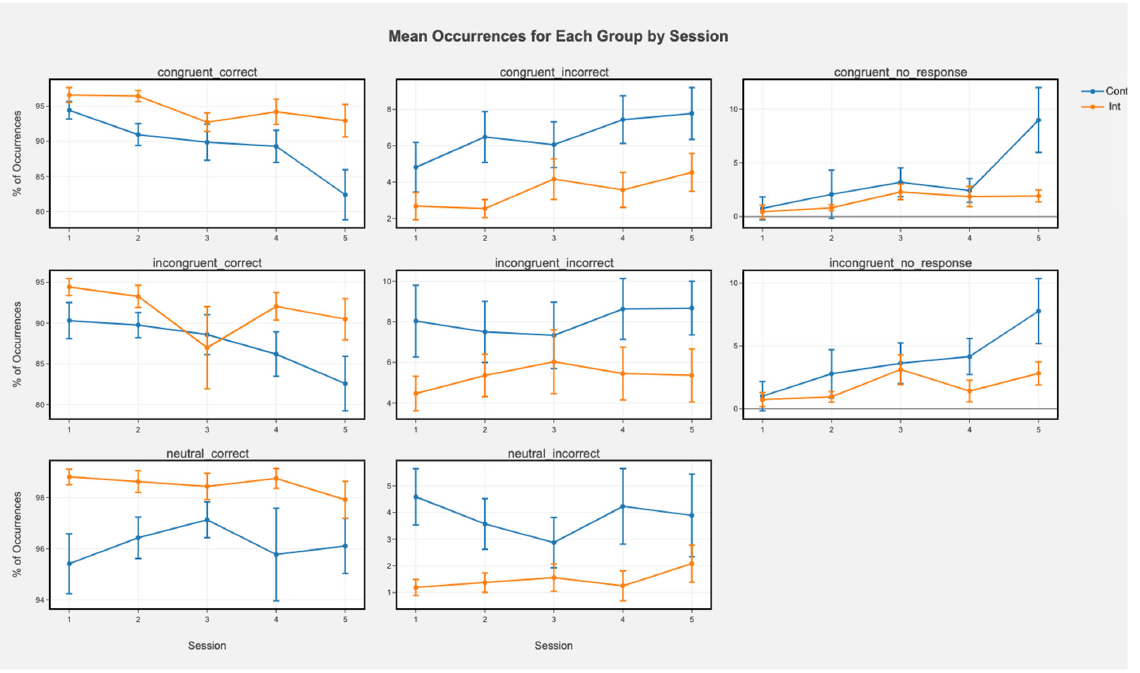
Figure 2. Mean occurrences (%) of each trial type for each group by session in the Stroop task. Greater % of correct trials means greater accuracy, while greater % of incorrect means lower accu ‐ racy (more errors). Error bars represent +/ − SEM. Cont represents the control condition and Int rep ‐ resents the intervention condition.